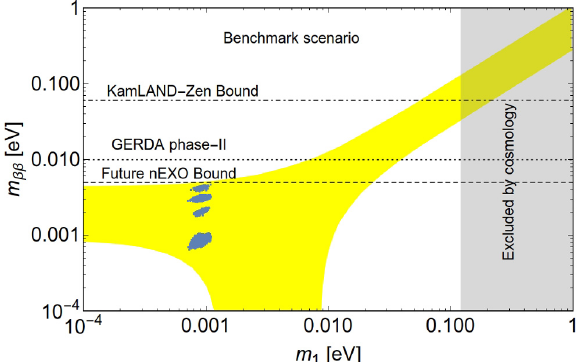
Figure 6 . Neutrinoless double beta decay in the benchmark scenario resulting from MCMC analysis. Cosmological exclusion bound (on the sum of the neutrino masses) is taken from ref.